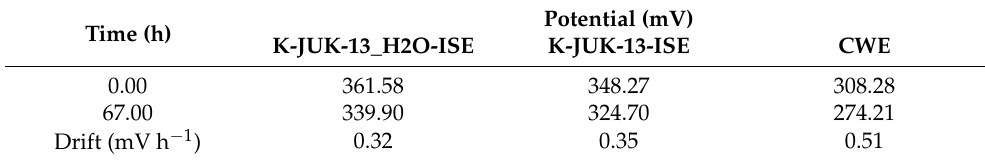
Table 1. Long-term potential stability of the studied solid contact and coated wire electrodes. Potential (mV) Time (h) K-JUK-13_H2O-ISE K-JUK-13-ISE CWE 0.00